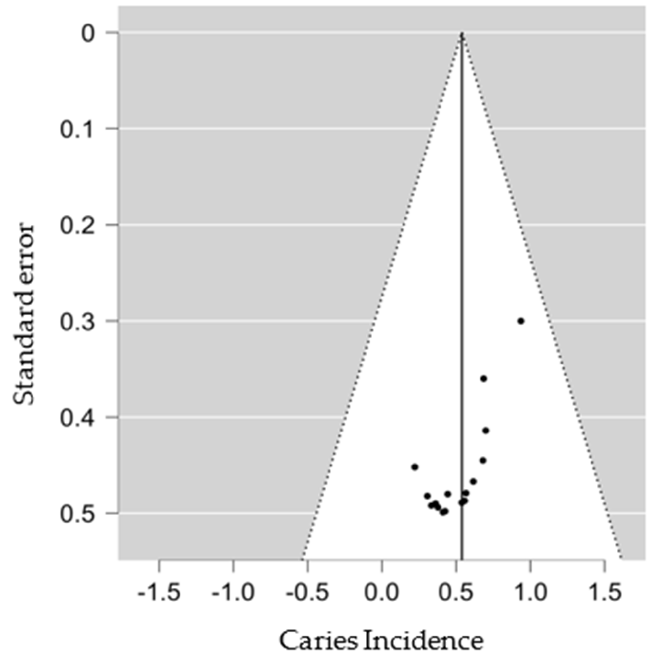
Figure 4. SD group Funnel Plot.